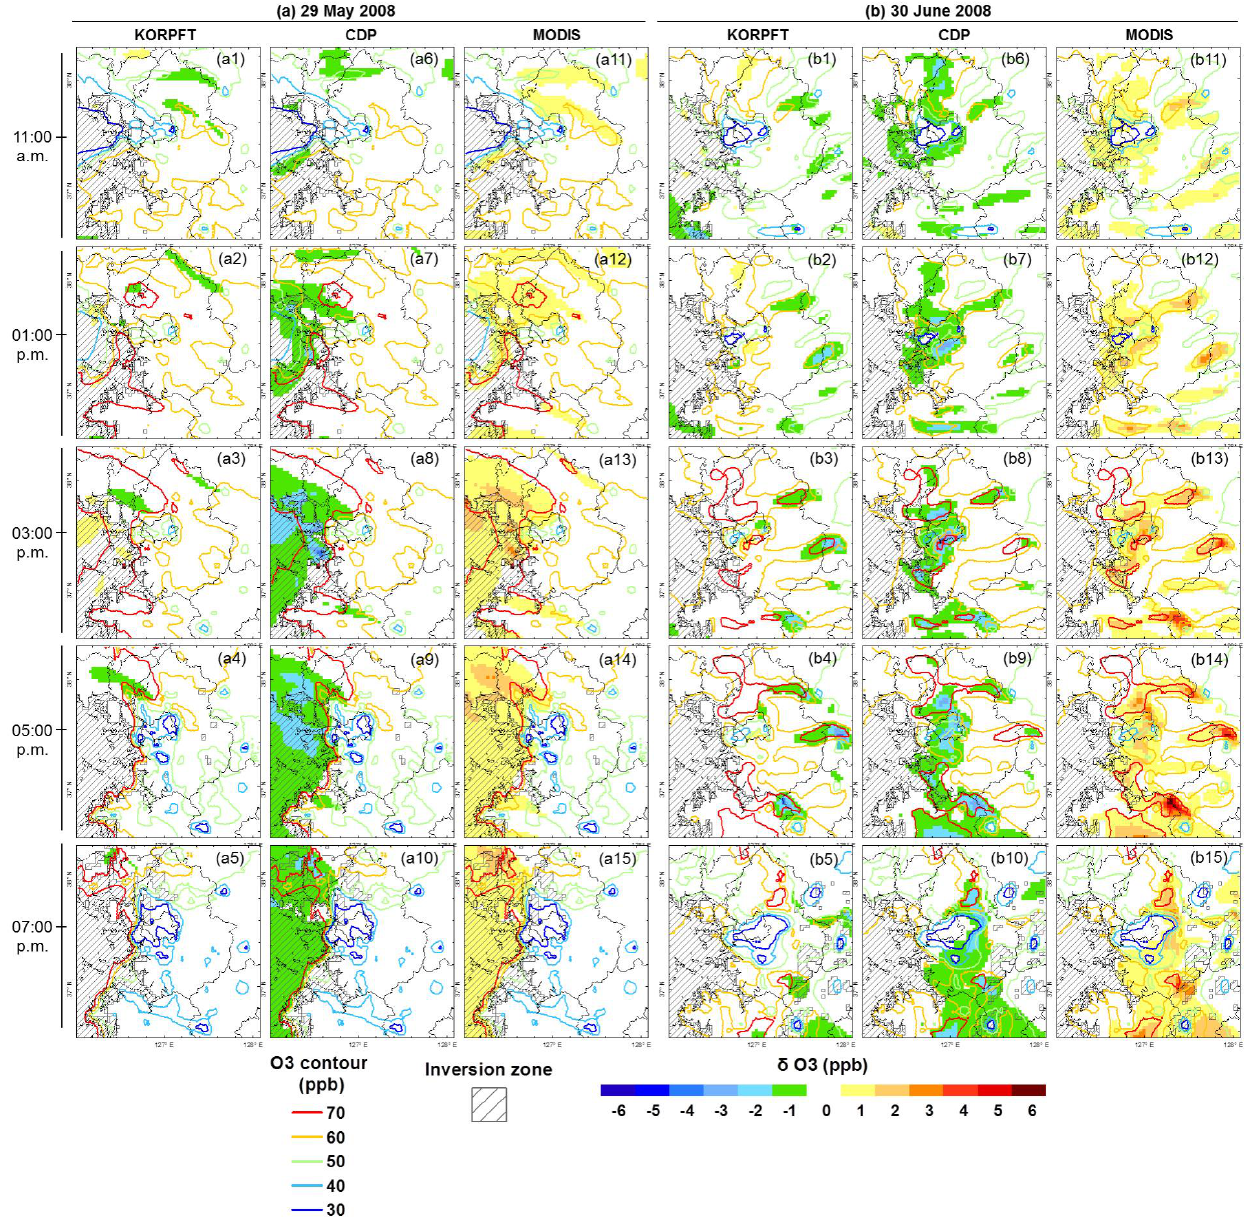
Figure 9. Spatial distributions of CMAQ O 3 hourly deviations for each BVOC emission scenario and CMAQ mean O 3 hourly concentrations. The CMAQ mean O 3 hourly concentrations are the averaged values of CMAQ O 3 concentrations for the three PFT scenarios. These CMAQ O 3 concentrations are illustrated by the contour. The grey-hatched lines represent the temperature inversion